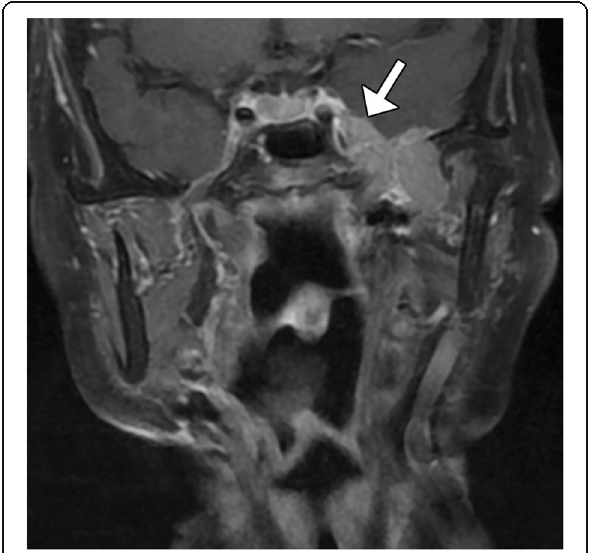
Fig. 9 High-grade transformation of polymorphous low-grade adenocarcinoma originating from the parotid gland with perineural spread. Coronal fat-suppressed post-contrast T1-weighted MRI shows a mass in the left intratemporal fossa that extends through a widened foramen ovale into the left cavernous sinus (arrow)